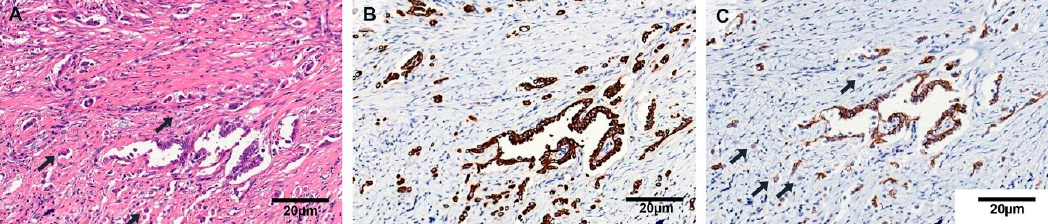
Figure 3. Tumor budding in cPTC. ( A ) A high magnification view showed cPTC with a single tumor cell or small clusters of tumor cells in fibrotic stroma at the periphery (×400). ( B ) These tumor buddings were positive for cytokeratin immunohistochemistry (×400). ( C ) Membranous E-cadherin